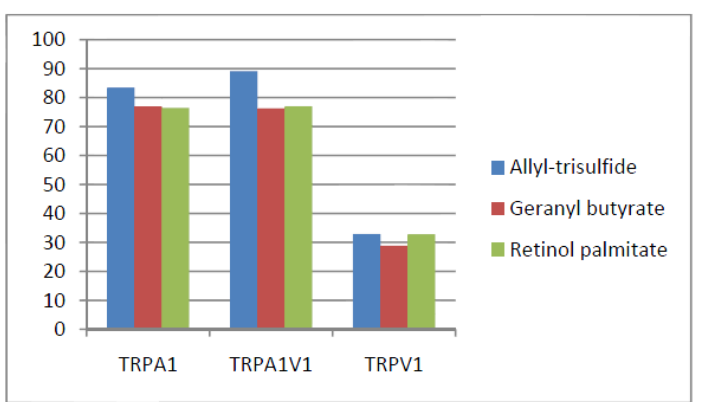
Figure 3. Examples of compounds that activated all three receptors (TRPA1 = TRPA1V1 >